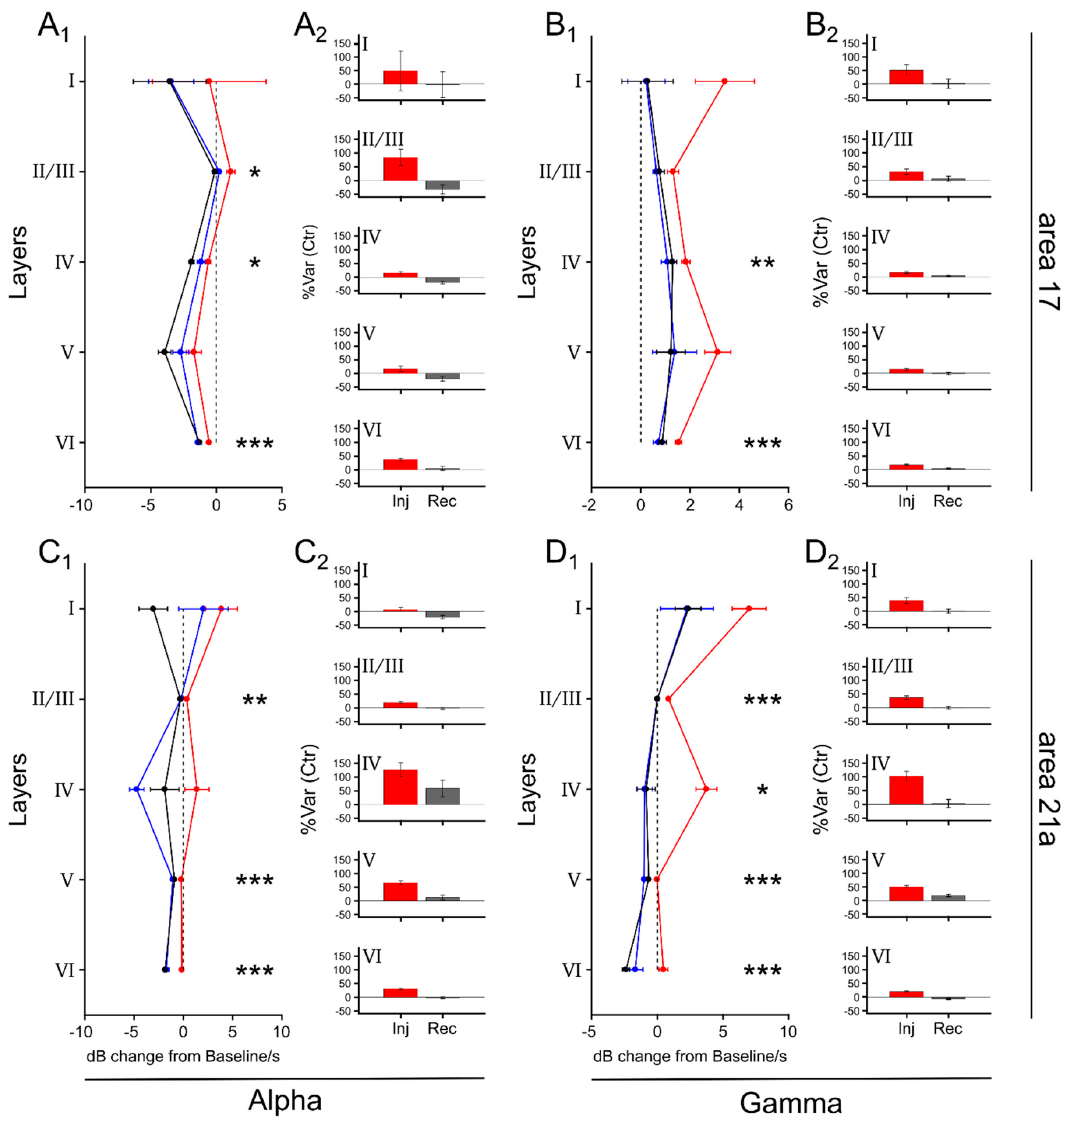
Figure 5. E ff ect of LPl inactivation in alpha- and gamma-band frequency for layers in areas 17 and 21a, respectively. (1) Values represent average relative LFP power spectra (dB change from the baseline / s). This parameter measures the amplitude of cortical oscillations in response to drifting gratings before (Ctrl, blue lines), during (Inj, red lines) and after (Rec, black lines) LP inactivation. (2) Var%(Ctr) across layers for periods during and after the thalamic inactivation. ( A ) and ( B ) alpha waves and gamma waves for in area 17, respectively. ( C ) and ( D ) alpha waves and gamma waves for in area 21a, respectively. Symbols in panels ( A1 ), ( B1 ), ( C1 ) and, ( D1 ) only are for significant di ff erences between Ctrl and Inj conditions. * P < 0.05, ** P < 0.01, *** P < 0.001.